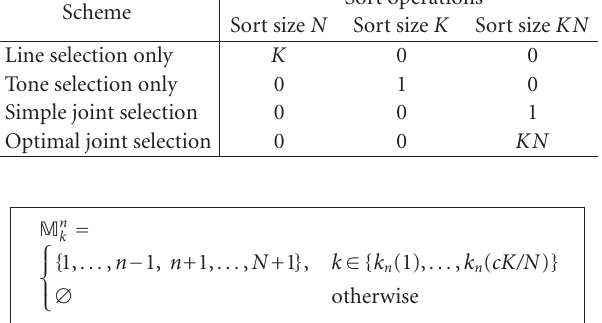
Algorithm 3: Simple tone-line